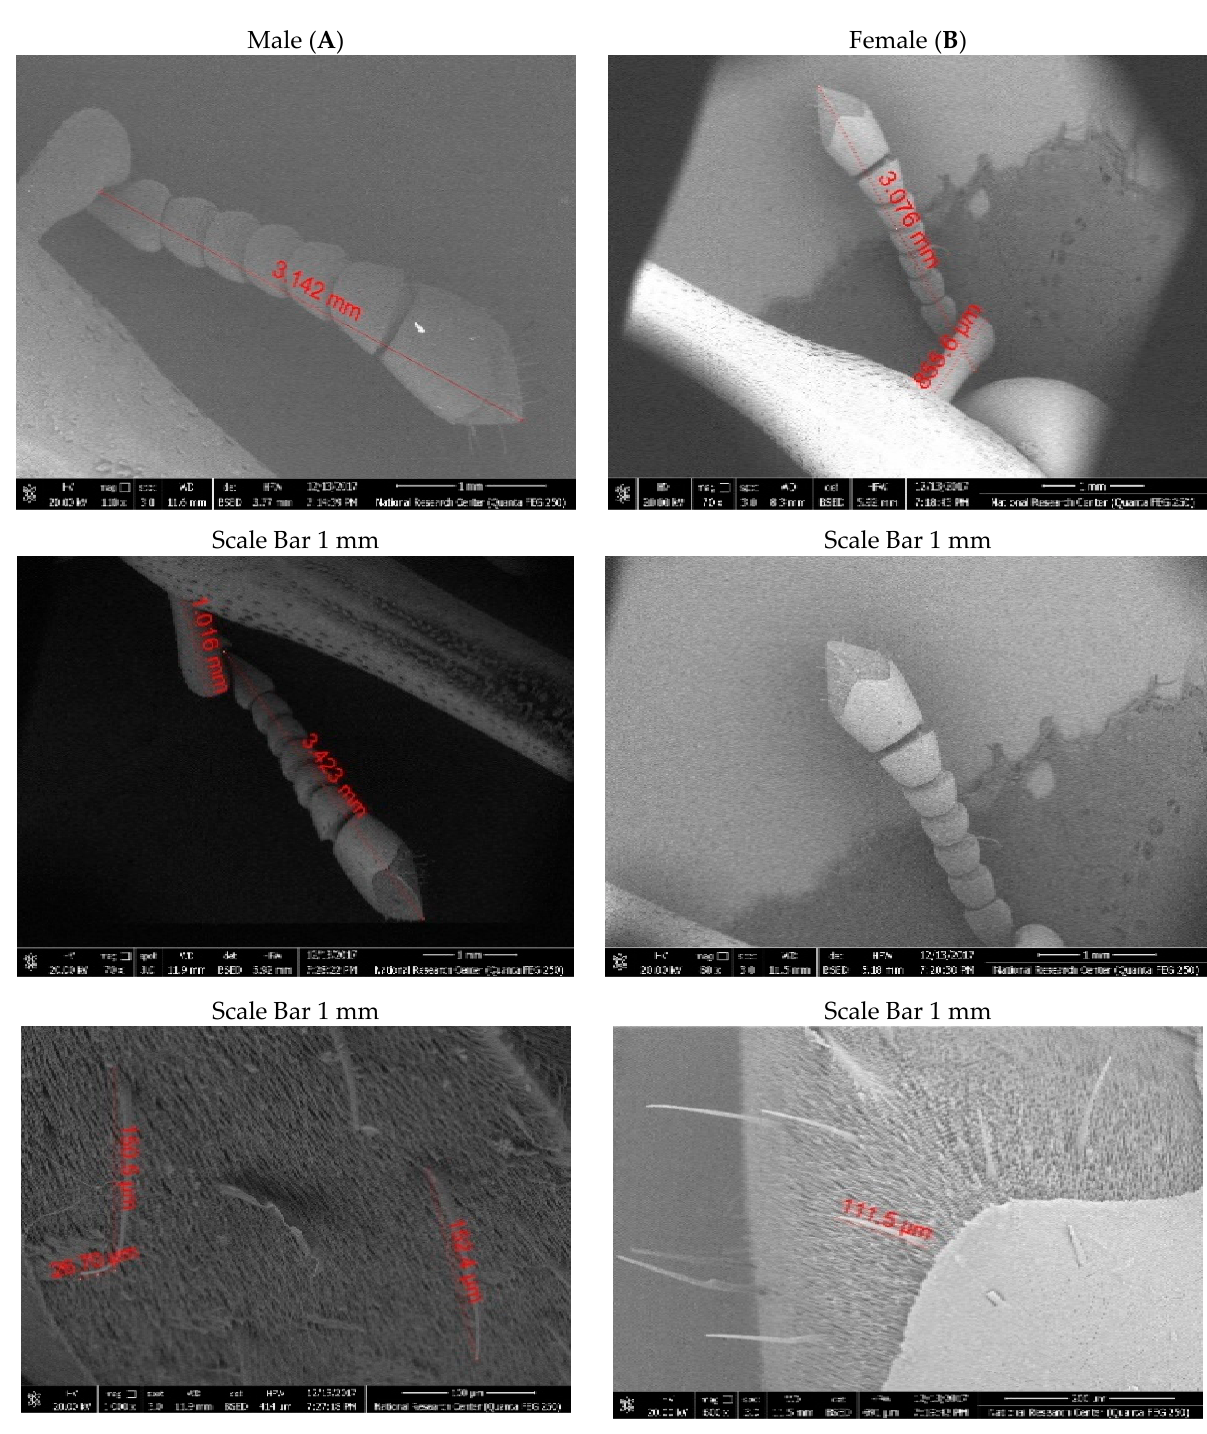
Figure 5. SEM of antenna of male ( A ) and female ( B ) R. ferrugineus adults, showing high variability (note: p > 0.05, n = 13 random individuals/sex), (scale bar below each picture and measurements are shown in the picture).